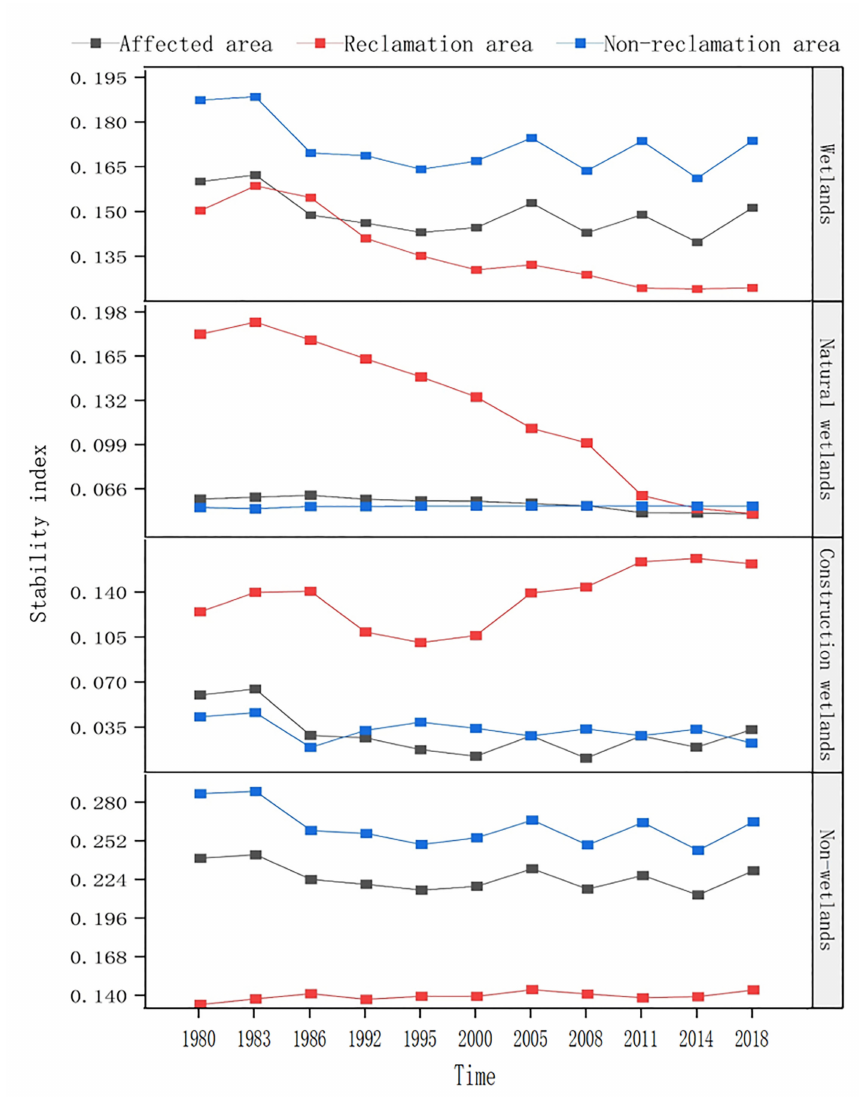
Figure 5. Temporal variation of different wetland types in different